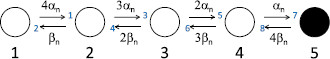
Illustration of the Hodgkin–Huxley potassium channel state graph. This is a 5-state chain where state 5 is the conducting state. The eight reactions are labeled in blue and are used to define the edge importance values Rk in the figures below. The reaction rates αn and βn are voltage-dependent as defined by Eqs. 47–48